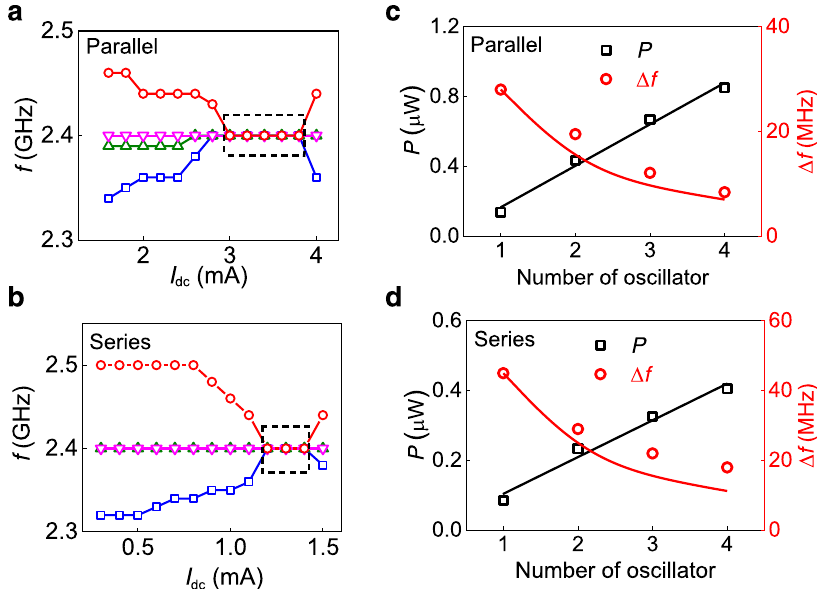
Fig. 2 Output frequency and power of the four synchronized STOs. a , b Evolution of the frequency ( f ) of the four interacting STOs as a function of dc bias ( I dc ) for parallel ( a ) and series ( b ) connection. The synchronization condition is indicated by the black dotted boxes. c , d Maximum power ( P ) and minimum linewidth ( Δ f ) with the different numbers of oscillators ( N ) in parallel ( c ) and series ( d ), respectively. Solid lines are linear fi t and N − 1 scaling for the power and linewidth from single to four oscillators, respectively. The I dc and magnetic fi eld are adjusted for N oscillators for the maximum power and minimum linewidth at 2.4 GHz. For example, for the four synchronized oscillators, the I dc and H are 3.4 mA (1.3 mA) and 150 Oe (120 Oe) for the parallel (series) con fi guration,